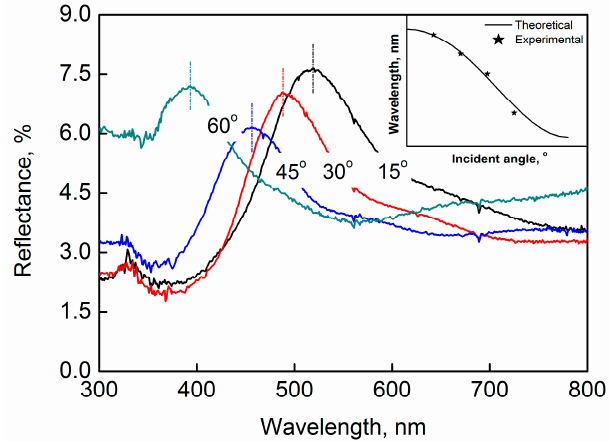
Figure 2. Photographs of the product: ( a – d ) microscopic photographs with different magnifications under white illumination; and ( e ) scanning electron microscope (SEM) photographs.